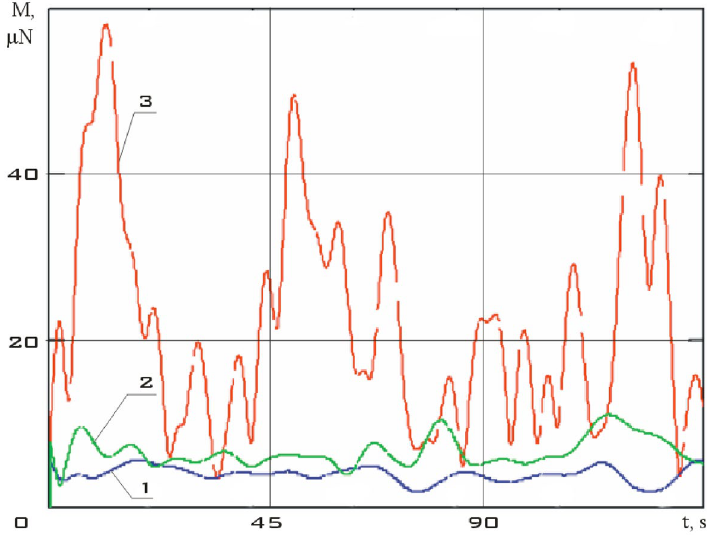
Figure 18. There are modulus of the disturbing moment in the coordinate system CXYZ . 1 is 01/11/2014 from 01:45:14 to 01:48:20; 2 is 01/14/2014 from 04:41:15 to 04:44:21; 3 is 02/15/2014 from 12:00:06 to 12:02:21.